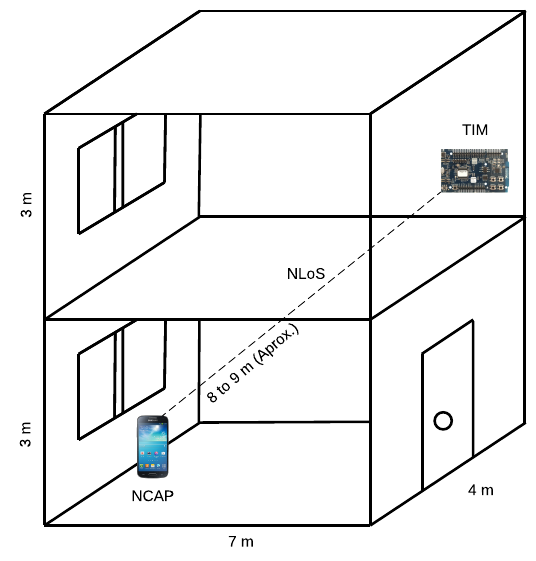
Figure 35. Physical scenario of the experiment with NLoS.